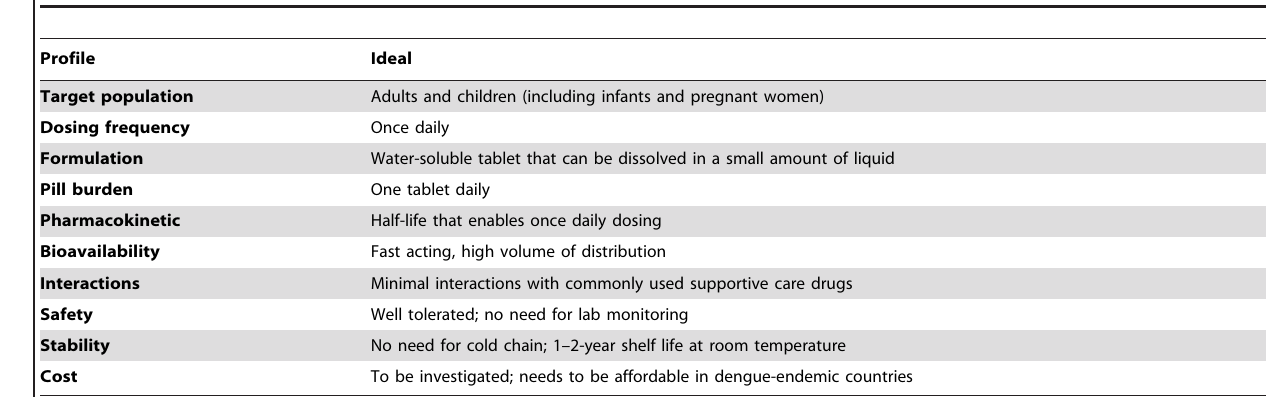
Table 1. Target product profile for a dengue